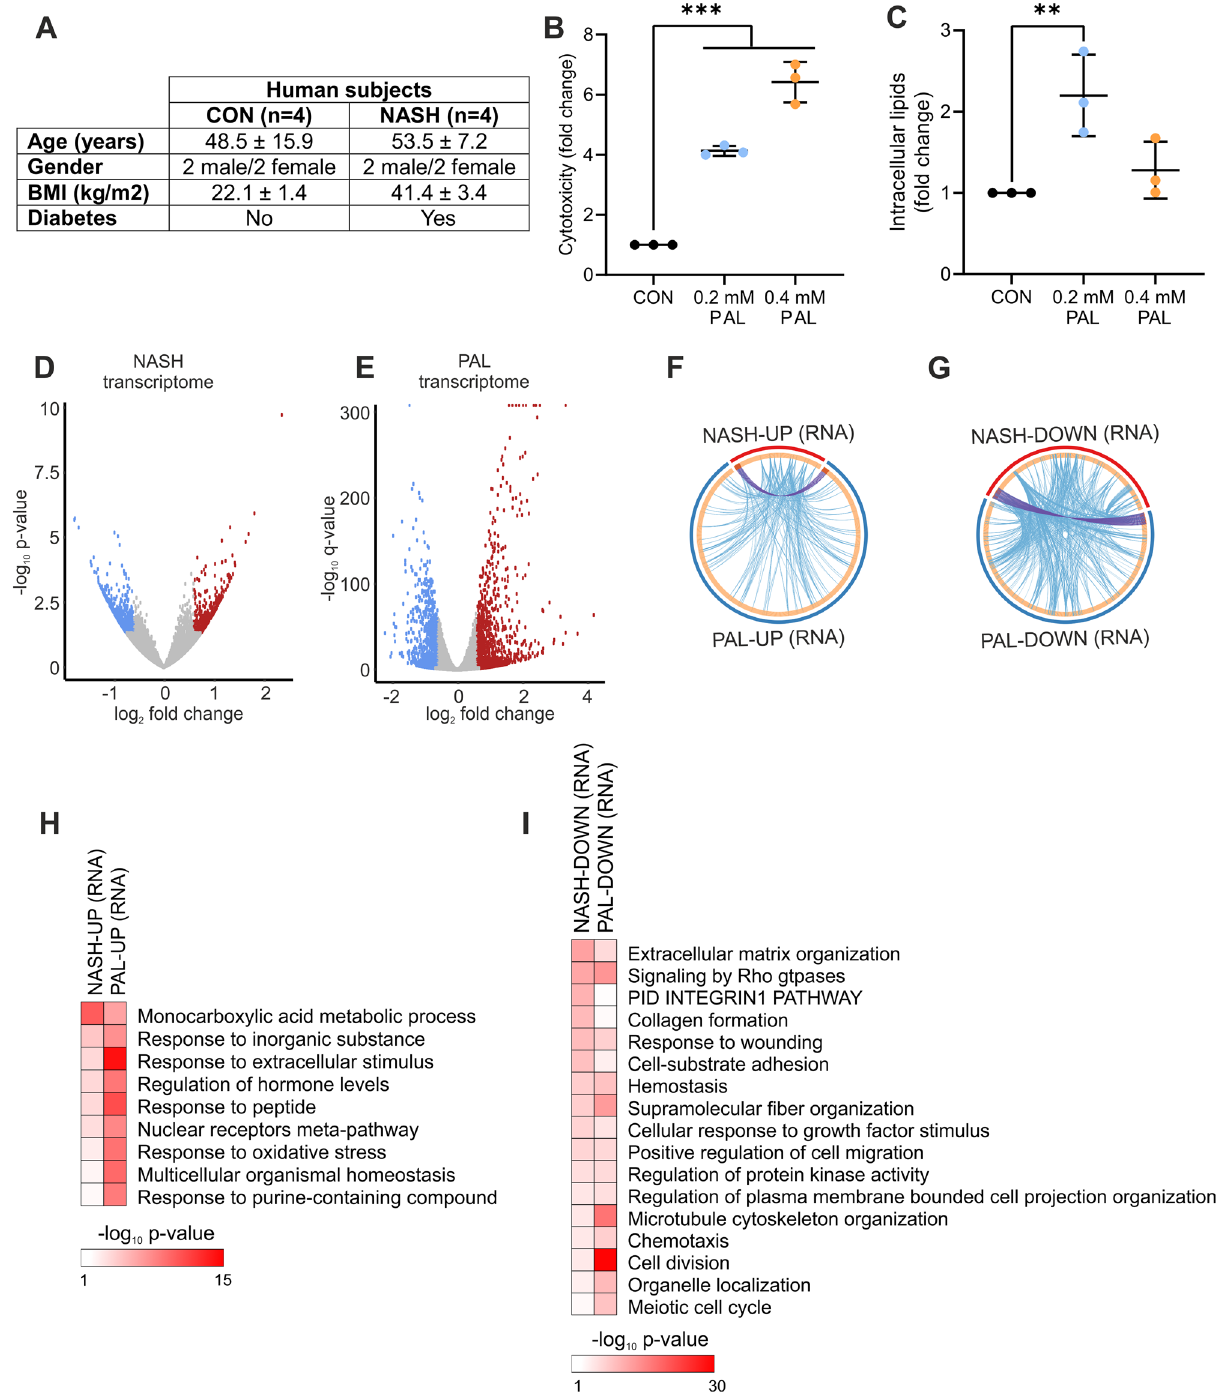
Figure 1. Shared transcriptional response in NASH and lipotoxicity. ( A ) Characteristics of human subjects. ( B , C ) Mouse hepatocytes were stimulated with BSA (control) or PAL for 24 h, and ( B ) cytotoxicity and ( C ) intracellular lipid content were measured (n = 3 independent experiments; values are mean ± SD; **p < 0.01, ***p < 0.001). ( D , E ) Volcano plots showing differentially regulated genes in ( D ) human liver from NASH patients (n = 4 per group) and ( E ) mouse hepatocytes stimulated with PAL for 24 h (n = 3 per group). Blue and red dots denote significantly down- and up-regulated genes, respectively. ( F , G ) Circular plots showing the gene (purple lines) and functional (blue lines) overlap between ( F ) up- and ( G ) down-regulated genes in human NASH and mouse hepatocyte lipotoxicity. ( H , I ) Gene ontology analysis showing biological processes significantly regulated in both human NASH and mouse hepatocyte lipotoxicity ( H ) up- and ( I ) down-regulated